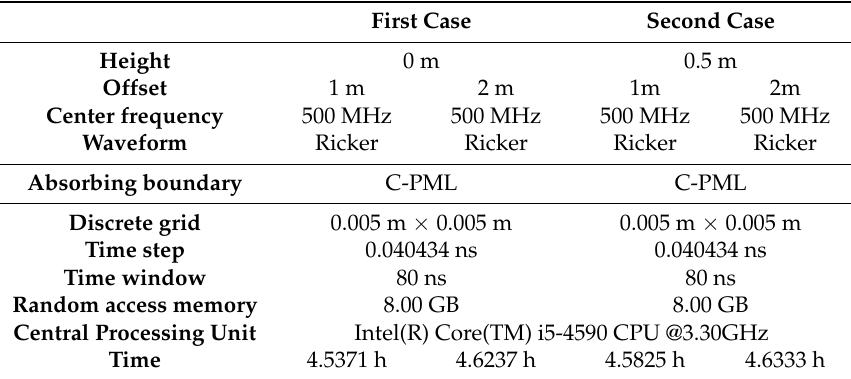
Table 1. Simulation Parameters.